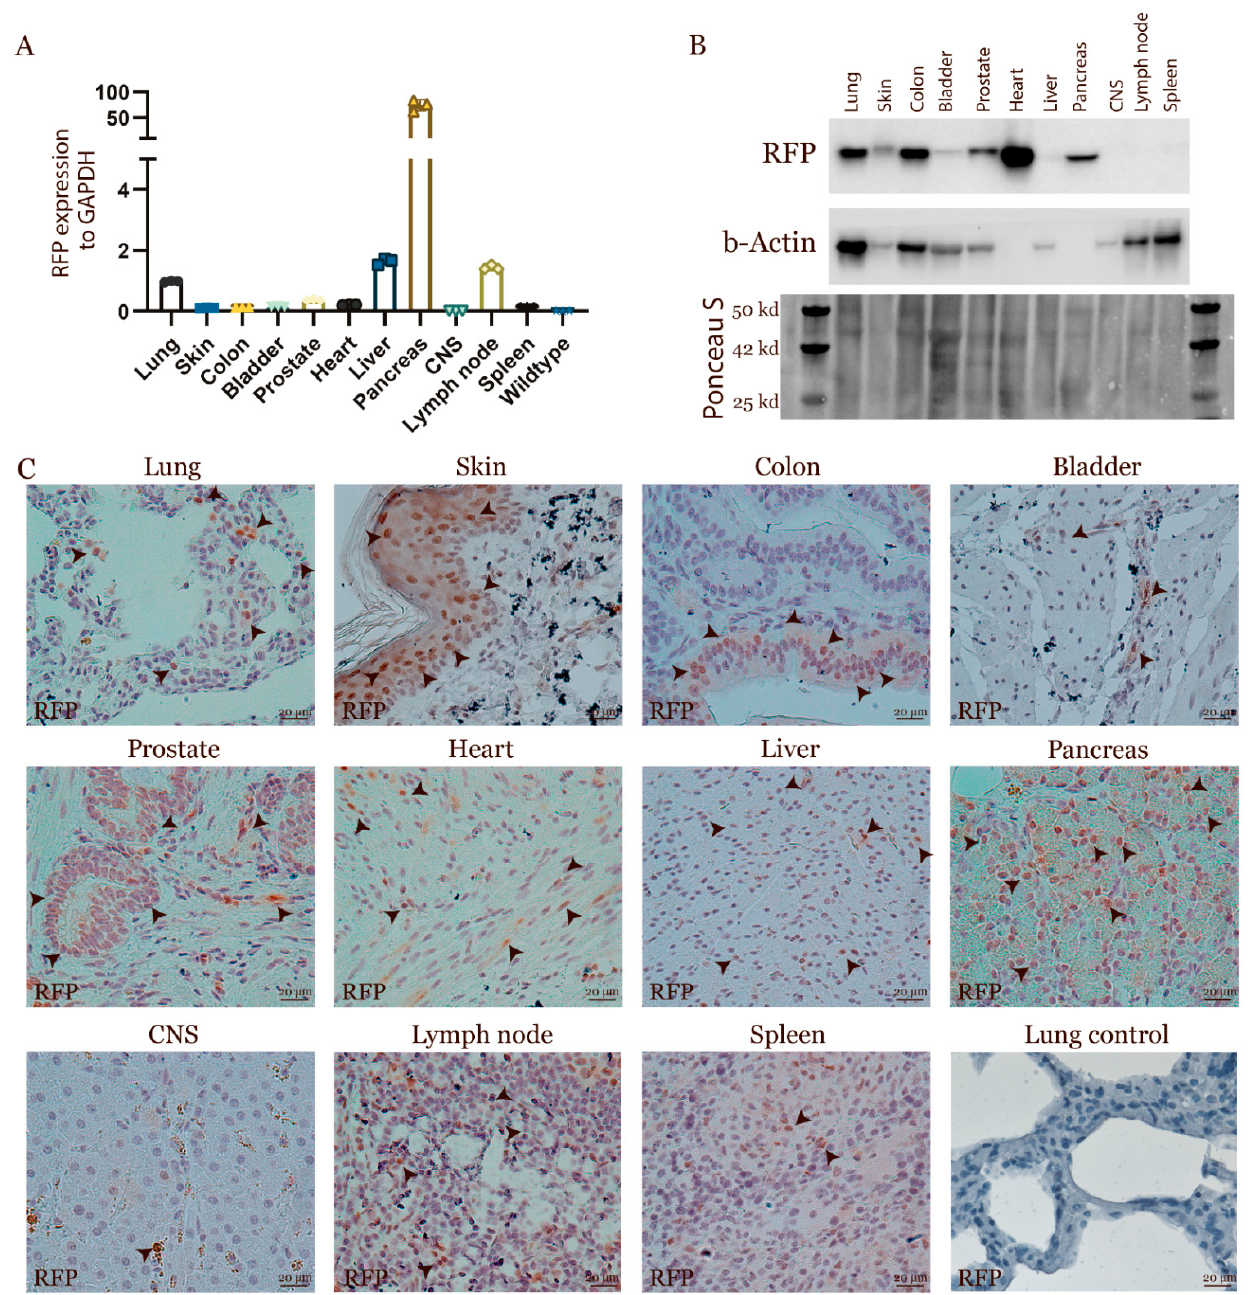
Figure 2. Expression profile of RFP in multiple organs. ( A ) Expression of RFP in multiple organs was assessed by qPCR. Expression was normalized to GAPDH, and the expression in lung tissues was set to 1 ( n = 3). ( B ) Western blot RFP was performed on samples from multiple organs. Equal amount of proteins were loaded, and beta-actin and Ponceau S were used as loading control. ( C ) Tissue sections for different organs were stained with an antibody against RFP (brown stain). Arrowheads mark the positive cells. Haematoxylin staining was used to stain the nucleus of the cells (blue stain) ( n > 3). Western Blot Images can be found in Figure S7.